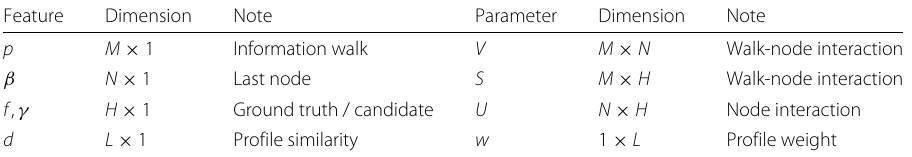
Table 1 Dimension of the model parameters/features in Eq.